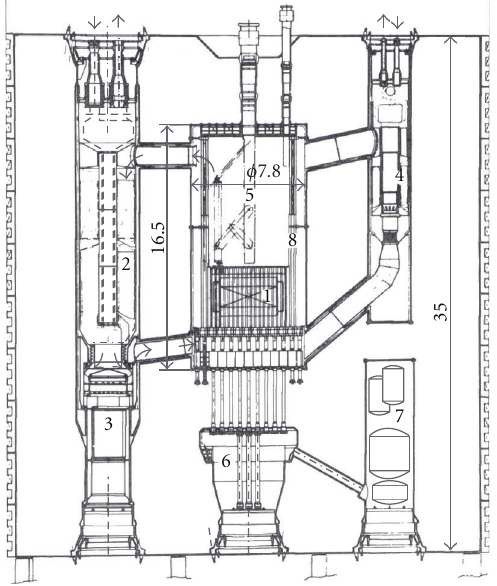
Figure 3: Vessel cross section of the PCRV for GBR-4 (1200 MWe). All dimensions in m. 1: core, 2: main steam generator, 3: main gas circulator, 4: emergency cooling loop, 5: fuel manipulator, 6: